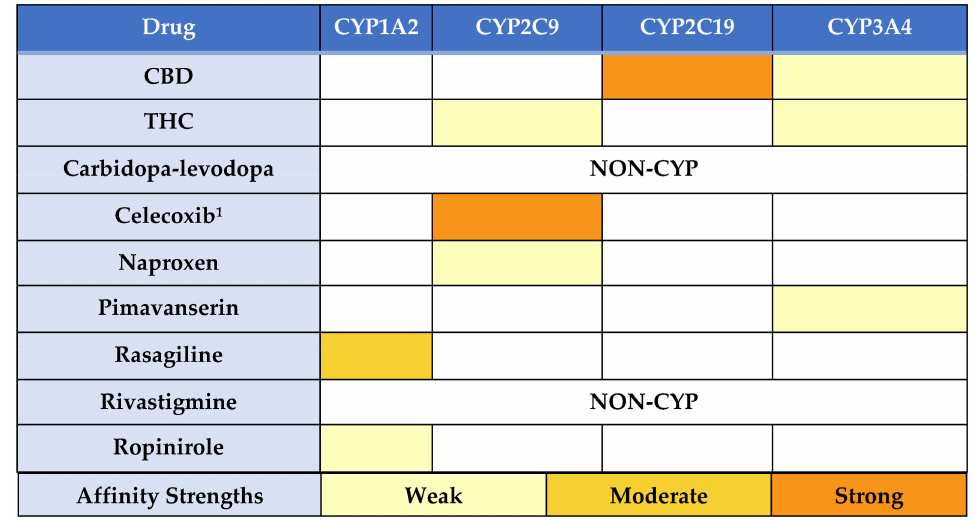
Figure 2. Summary of Affinity and CYP Metabolic Pathways. 1 Treatment with celecoxib began after the cessation of cannabis. Abbreviations: CBD: cannabidiol, CYP: Cytochrome P450, THC: